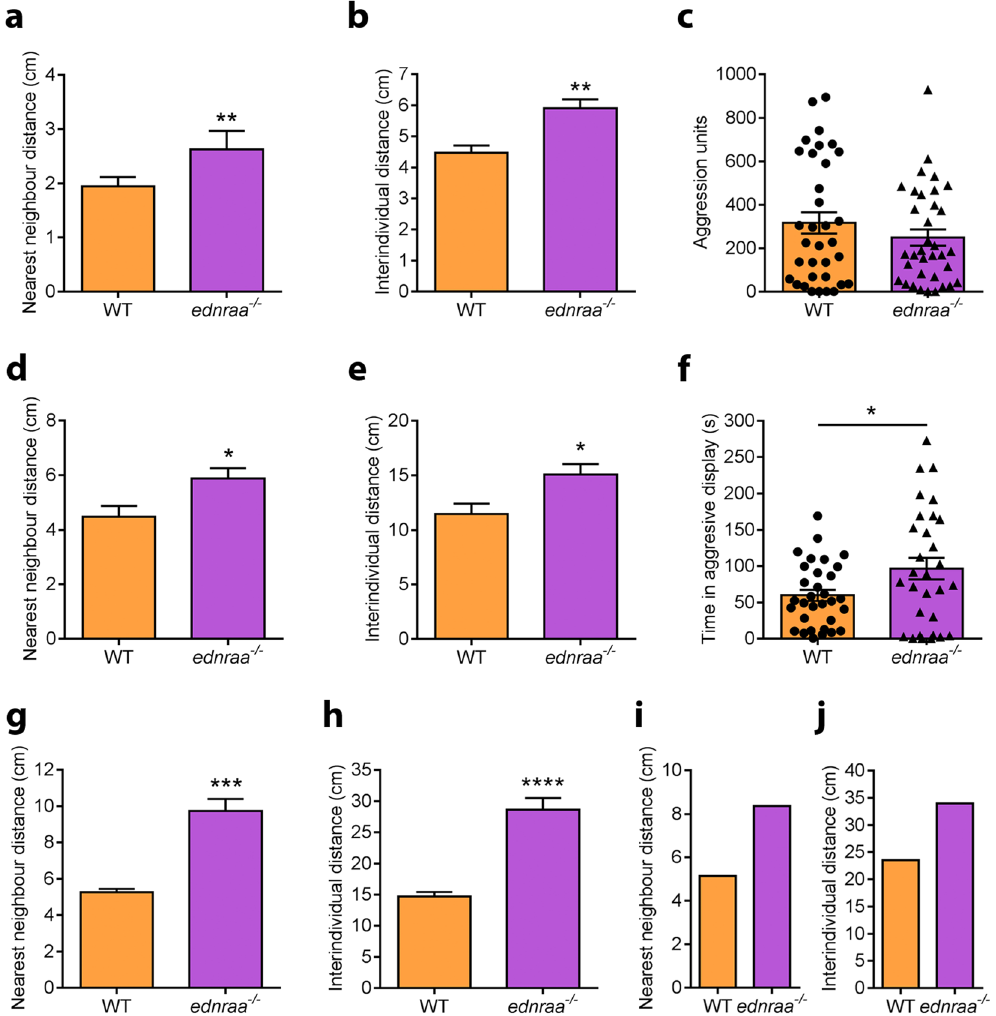
Figure 1. Alterations to social behaviour in ednraa − / − . ( a) Shoaling test. Increase in nearest neighbour distance in one-month old ednraa − / − compared to WT. (b) Shoaling test. Increase in inter-individual distance in 1-month old ednraa − / − compared to WT. (c) No difference in mirror-induced aggression levels between 1-month old ednraa − / − and WT quantified using Viewpoint ZebraLab software. (d) Increase in nearest neighbour distance in adult ednraa − / − compared to WT. (e) Increase in inter-individual distance in adult ednraa − / − compared to WT. (f) Adult ednraa − / − are more aggressive than WT in a mirror-induced aggression test. Manual quantification of data. (g) Shoaling test. Increase in nearest neighbour distance and (h) Shoaling test. Inter-individual distance between mutants and WT tested in a large tank. (i) Shoaling test. Average nearest neighbour distance and (j) Shoaling test. Inter-individual distance of 16 fish in a large tank. * p < 0.05, ** p < 0.01, *** p < 0.001, **** p < 0.0001. Each dot represents one